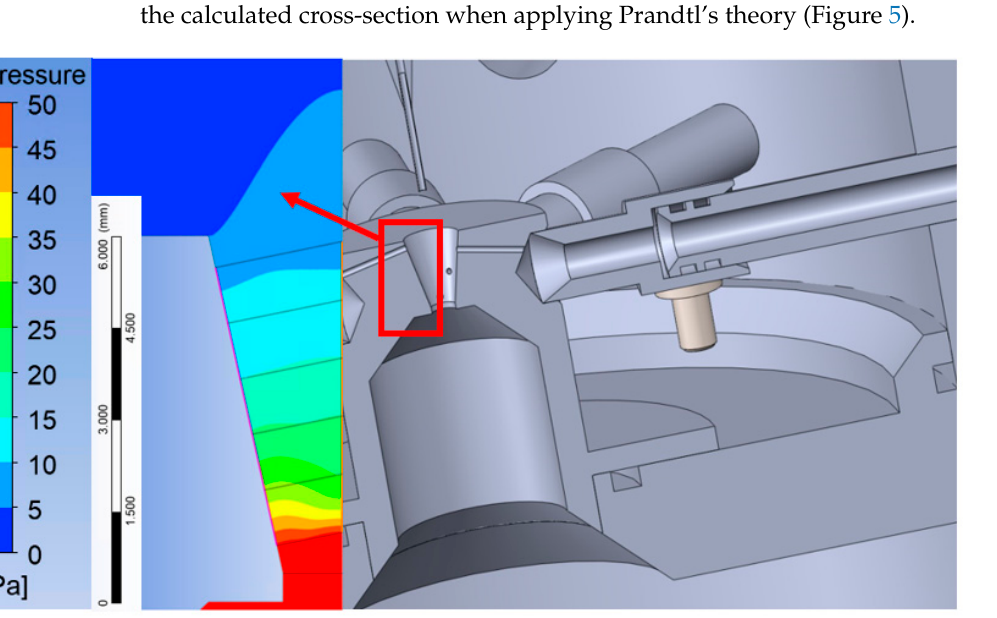
Figure 5. The shape of the conical Laval nozzle for Prandtl’s theory.